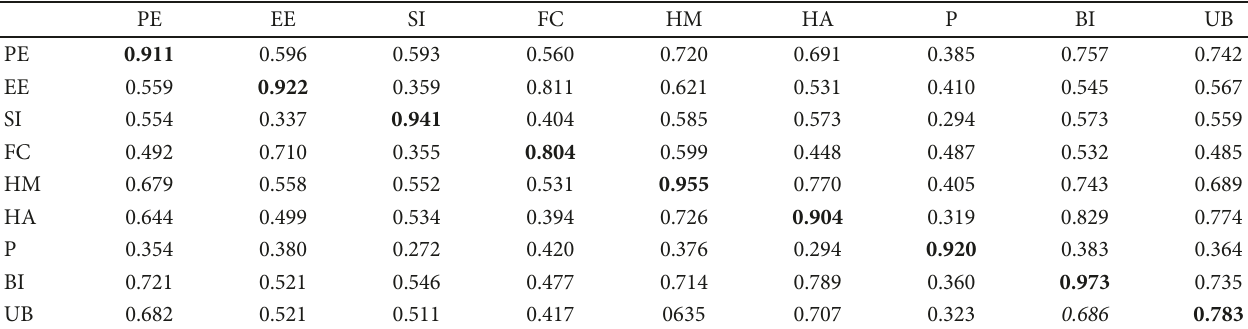
Table 3: Discriminant validity.